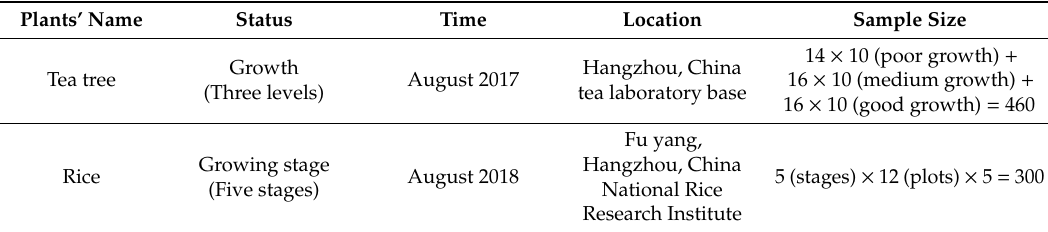
Table 2. Crop growth status monitoring information in Experiment 2.